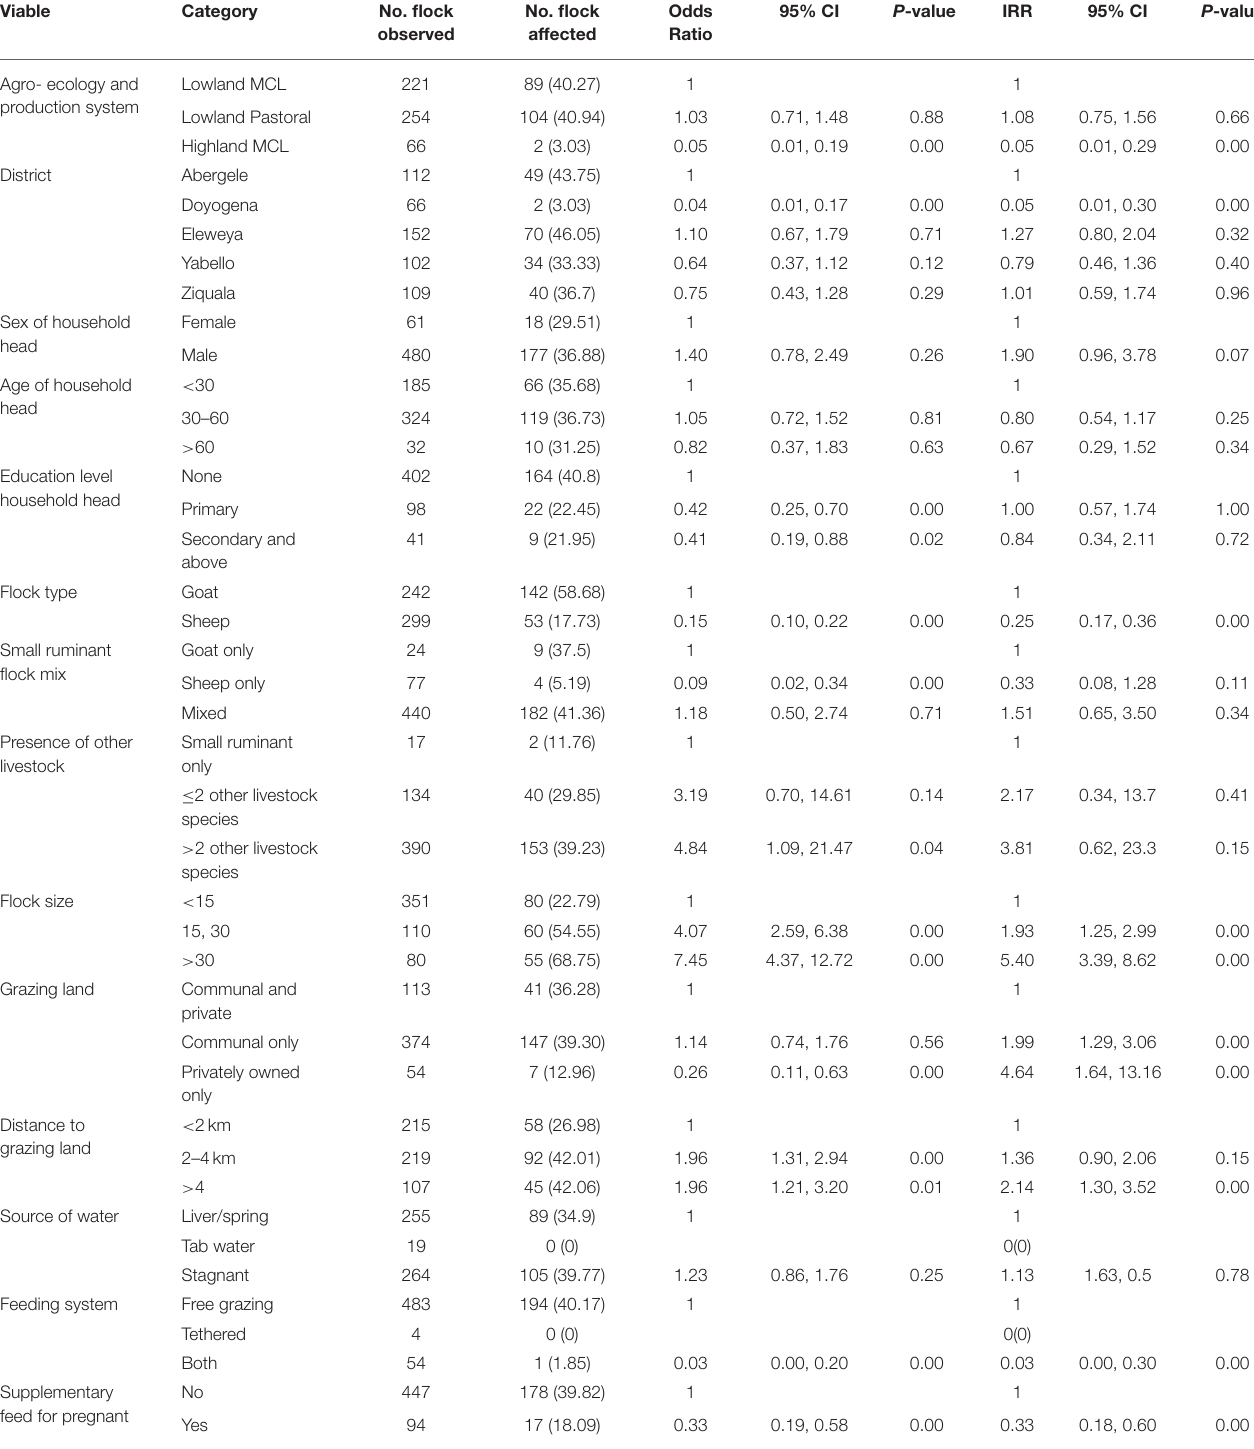
TABLE 5 | List of all predictors relating to small ruminant management practice, household demography descriptions, exposure to abortion pathogens and unconditional association with history of abortion and number of abortions.